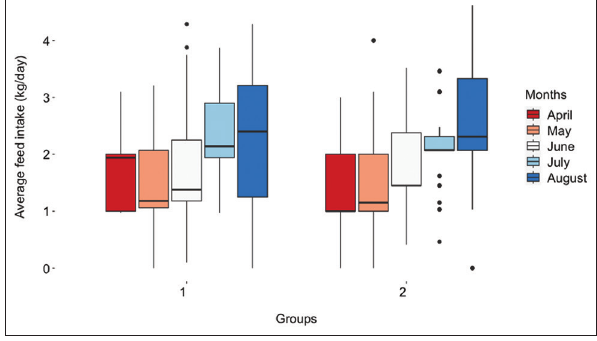
Figure-1: Average monthly feed consumption in two groups of replacements raised in an open barn. Feed consumption increased linearly as months advanced with the lowest record observed in April and the highest in Table-1: Comparing feed efficiency, environmental effect, selection rate, removal rate, and causes of removal for gilts.